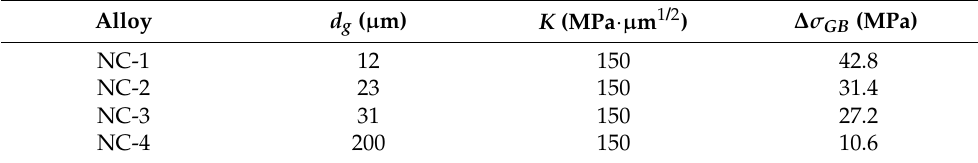
Table 5. Relevant parameters and theoretical values of the grain boundary strengthening.